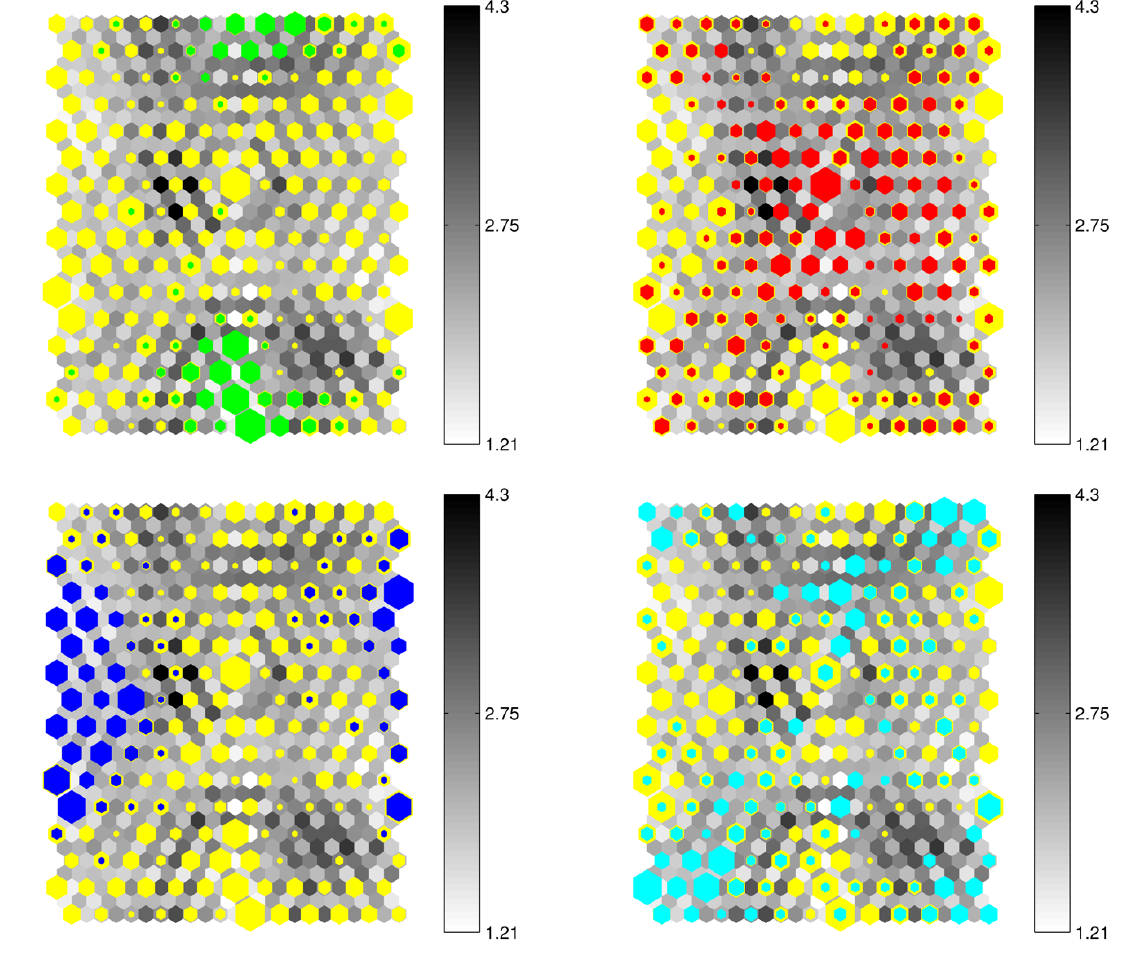
Figure 6. The individual SOM maps with the labeling of the experts for each of the four classes are displayed: green for the earthquake class, red for the landslide class, blue for the artificial explosion class and cyan for the class “other”. It is possible to note the different positions on the map of the four types of examined